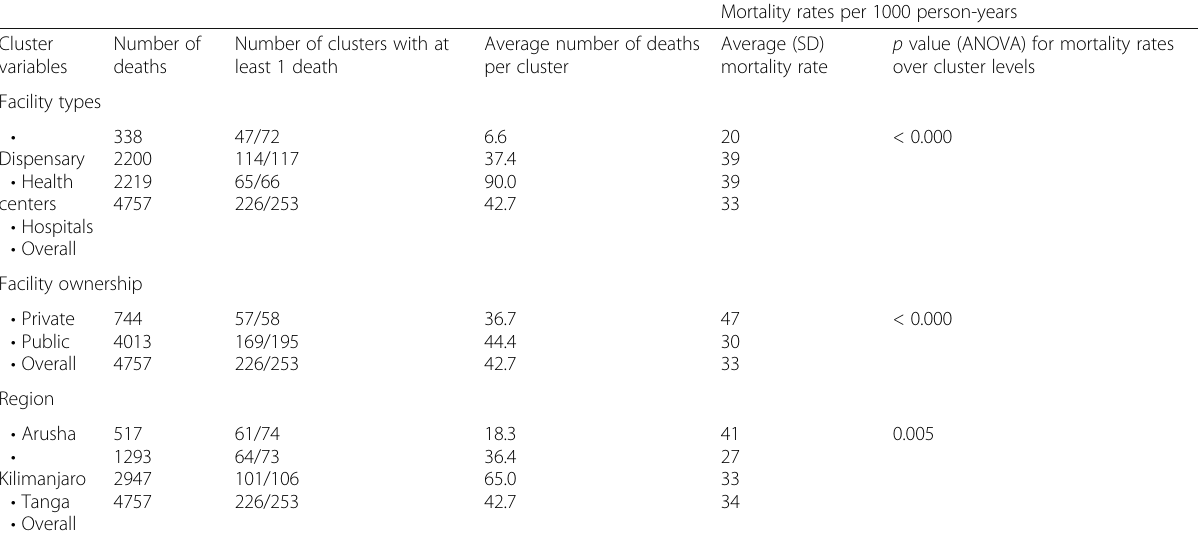
Table 2 Comparison of cluster level ’ s mortality rates per 1000 person-years among PLHIV in 253 health facilities in three regions of Northern Tanzania ( N = 88,934) Cluster Number of Number of clusters with at variables deaths least 1 death